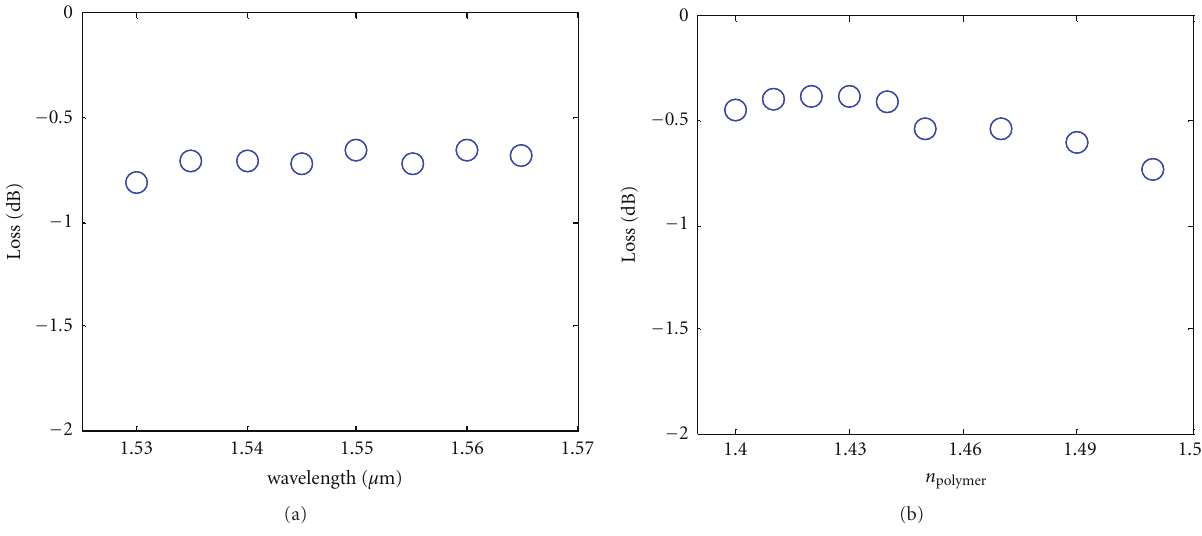
Figure 3: Loss variation with (a) wavelength and (b) polymer index.